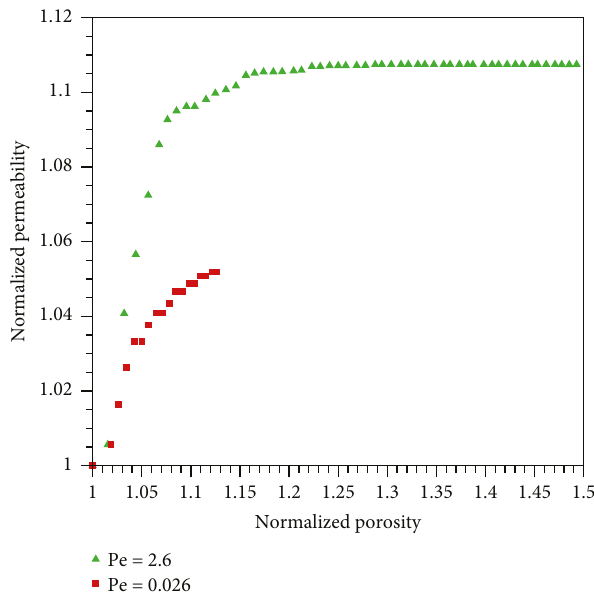
Figure 25: Normalized permeability versus normalized porosity at two di ff erent Pe numbers for an initially banded mineral assemblage (multispecies